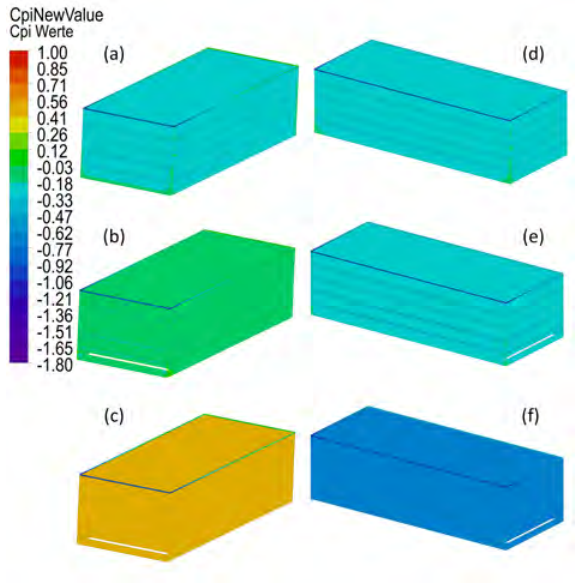
Figure 12. Distribution of the external pressure coefficients from a wind tunnel test for (a) the wind direction on the short face and (b) the wind direction on the long face ( TPU Aerodynamic Database [9],